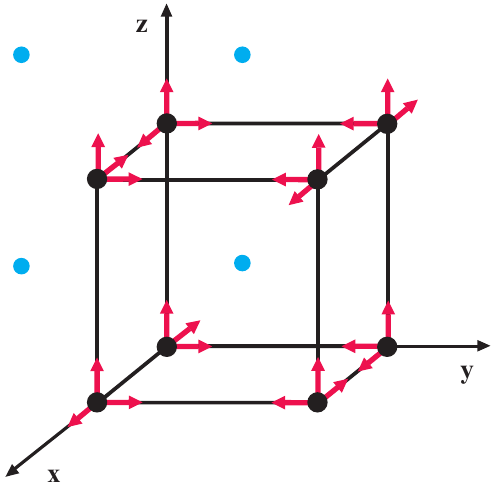
Figure 1. (Color online) Schematic presentation of the directions of the components of the Fe 3 + spins (black circle) and the position of the non-magnetic Y ions (blue circle) in the magnetic